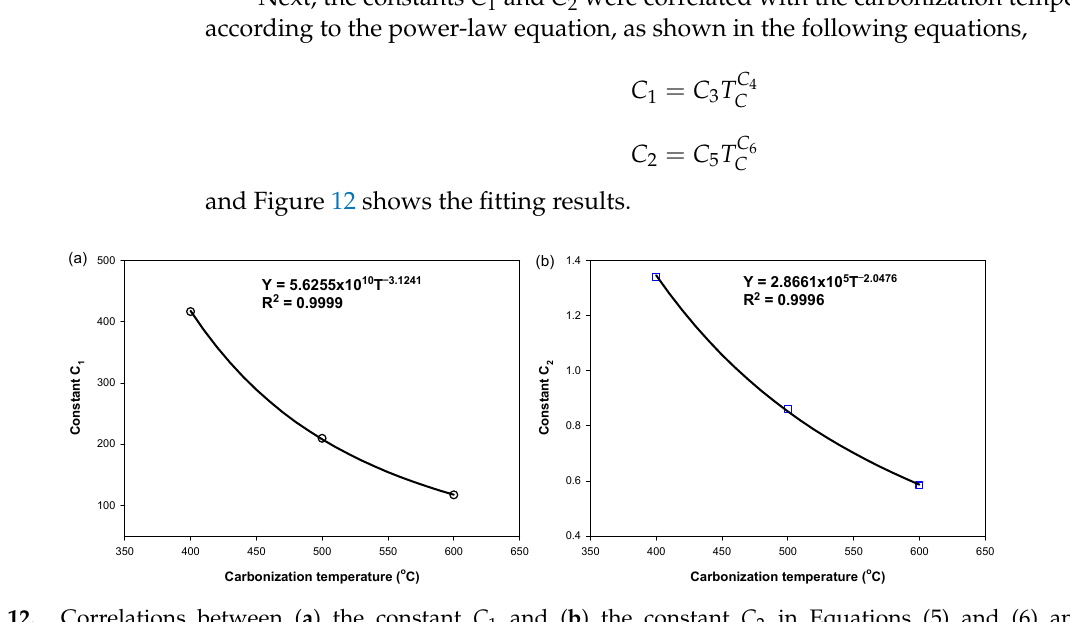
Figure 12. Correlations between ( a ) the constant C 1 and ( b ) the constant C 2 in Equations (5) and (6) and the carbonization